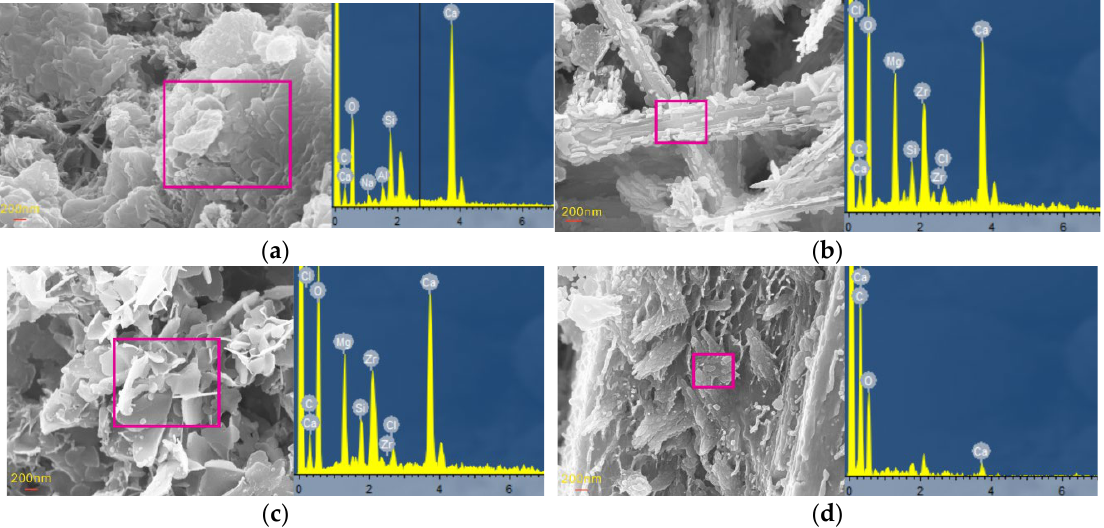
Figure 10. SEM images and EDS analyses after NaCl-MgSO 4 (CS1-M) erosion for 360 d: ( a ) C–S–H, ( b ) AFt, ( c ) M–S–H, ( d ) Ca(OH) 2